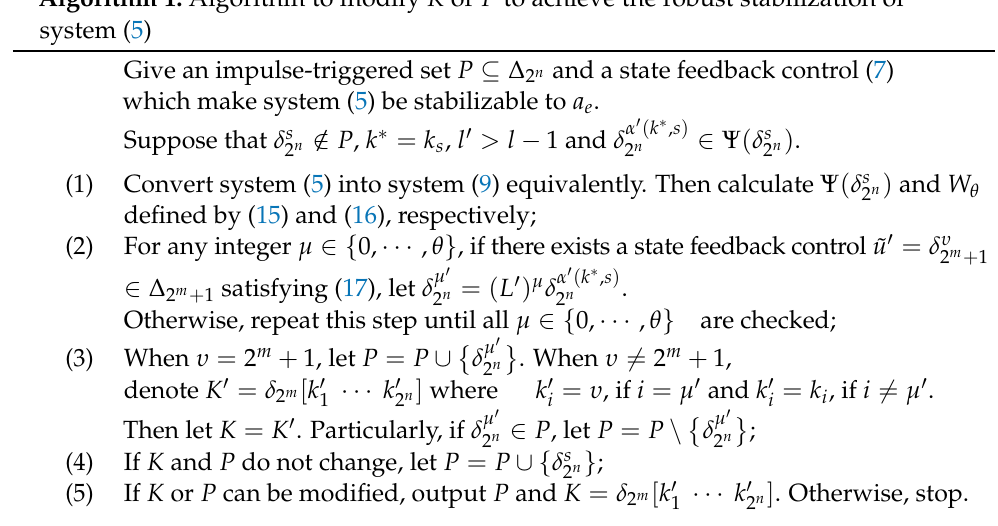
Algorithm 1: Algorithm to modify K or P to achieve the robust stabilization of system